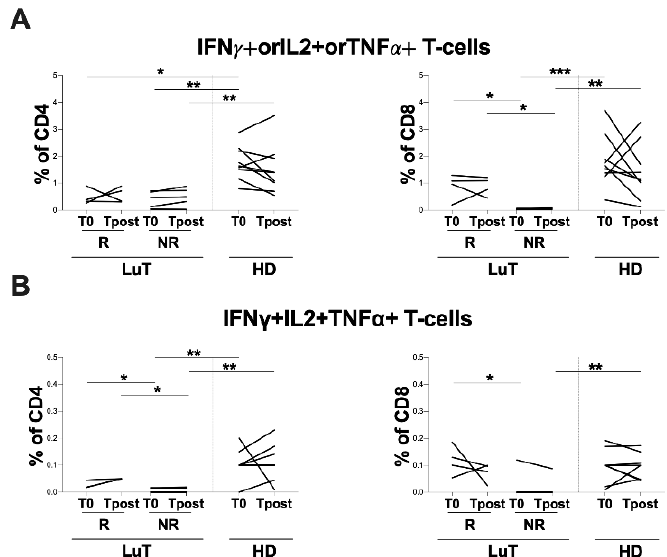
Figure 4. Longitudinal evaluation of T-cell response in LuT patients stratified in the R and NR groups. ( A ) The IFN γ +orIL2+orTNF α +CD4+ and CD8+ T-cell response was evaluated in the R and